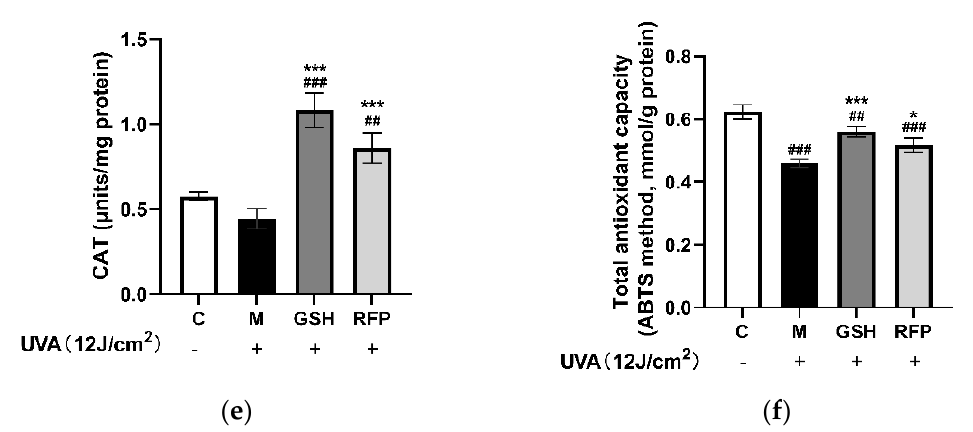
Figure 9. Effects of RFP on H&E staining and antioxidant capacity of mice skin tissues: ( a ) control group (double steam water); ( b ) model group (double steam water + UVA); ( c ) positive control group (1 g/L GSH + UVA); ( d ) sample group (1 g/L RFP + UVA); ( e ) effect on antioxidant capacity; and ( f ) effect on CAT activity. Single arrow indicates irregular epidermal hyperplasia; the double arrow points to the corner plug of the hair follicle. ## p < 0.002, ### p < 0.001 as compared to control group; * p < 0.033, *** p < 0.001 as compared to damage model group. Values do not have a common mark (#, *) when p > 0.033.